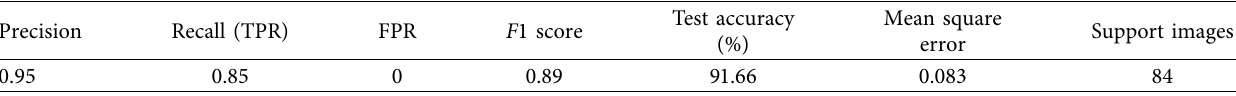
Figure 13: Random forest classifcation confusion matrix. Table 6: RF classifer